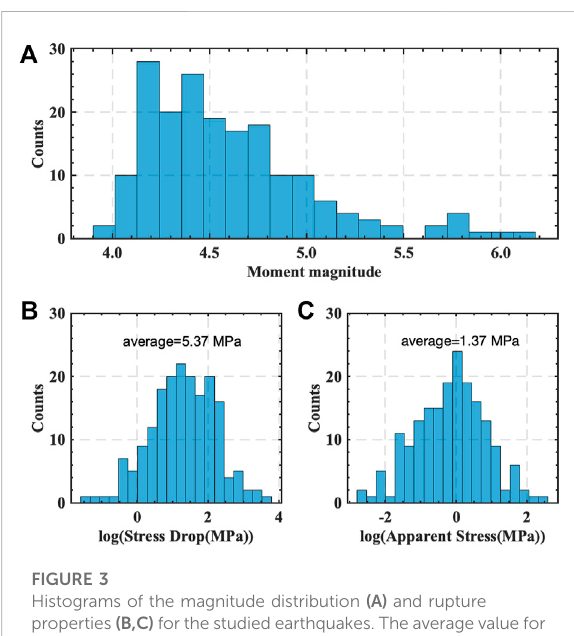
FIGURE 3 Histograms of the magnitude distribution (A) and rupture properties (B,C) for the studied earthquakes. The average value for the stress drop and apparent stress values are reported in each